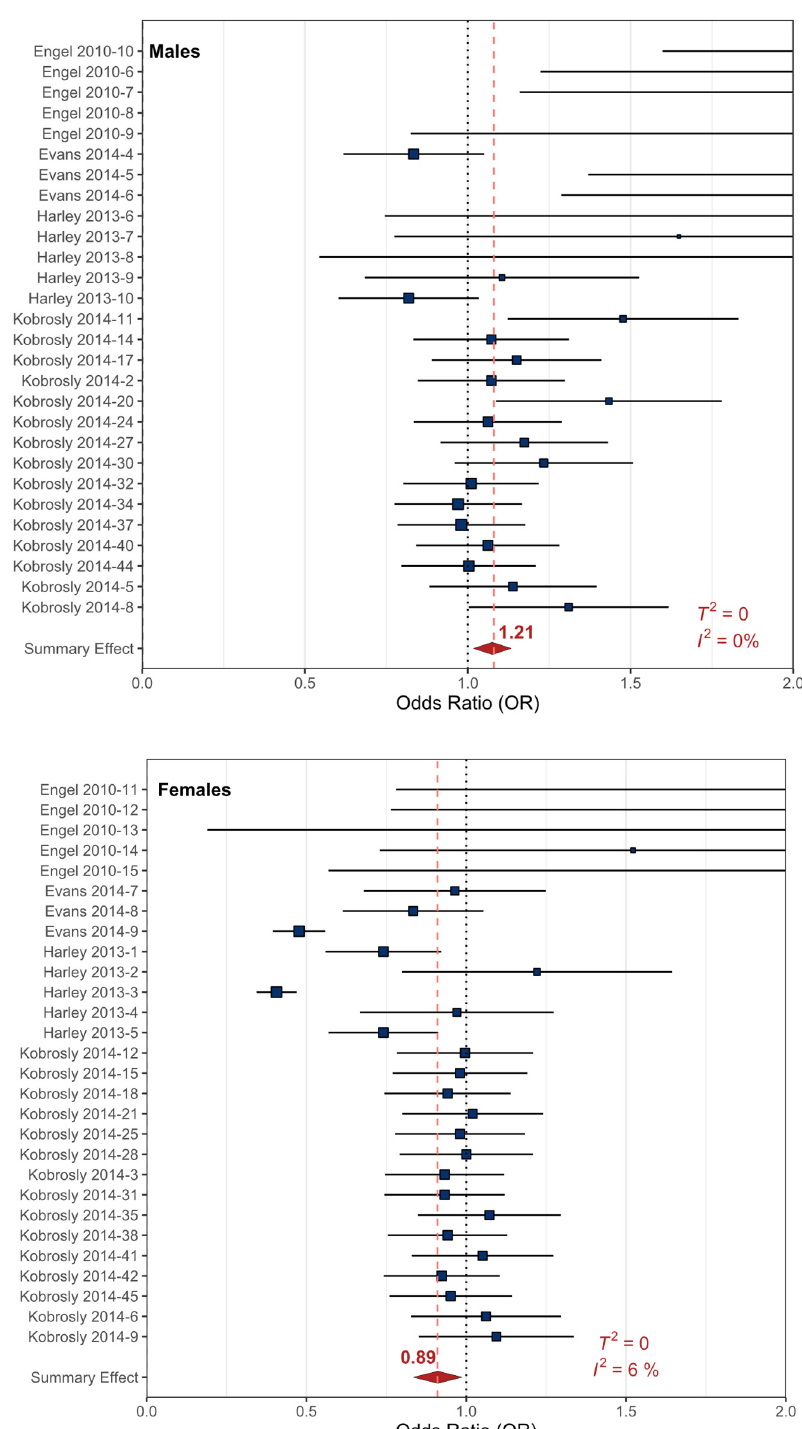
Figure 5. Forest plots showing the externalizing behavioral health outcomes included in the random effects meta-analysis for prenatal PhPl exposure. The squares represent the mean OR from each reference dataset (Table S5), horizontal error bars represent the upper and lower 90% CI, the size variation of the boxes represents the weight each dataset had in the meta-analysis with a larger size indicating larger weights. The diamond and dashed line represent the summary effect OR based on the meta-analysis. The ‘line of no effect’ at an OR of 1 is indicated with a dotted line.